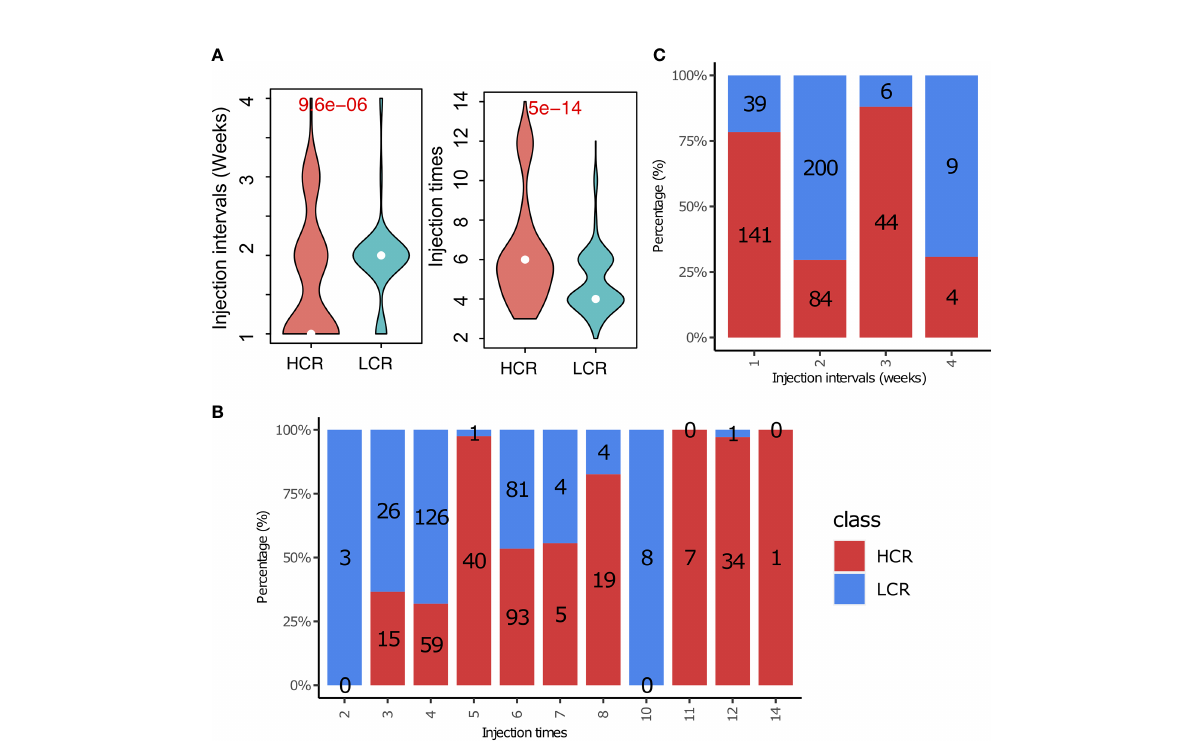
FIGURE 6 Treatment regimens play an important role in cancer immunotherapy. (A) The distribution of treatment regimens (injection interval) in HCR and LCR results. (B) The distribution of treatment regimens (injection times) in HCR and LCR results. (C) Comparison of treatment regimens (injection interval and injection times) between HCR and LCR results. P-values were calculated using two-sided Wilcoxon rank-sum